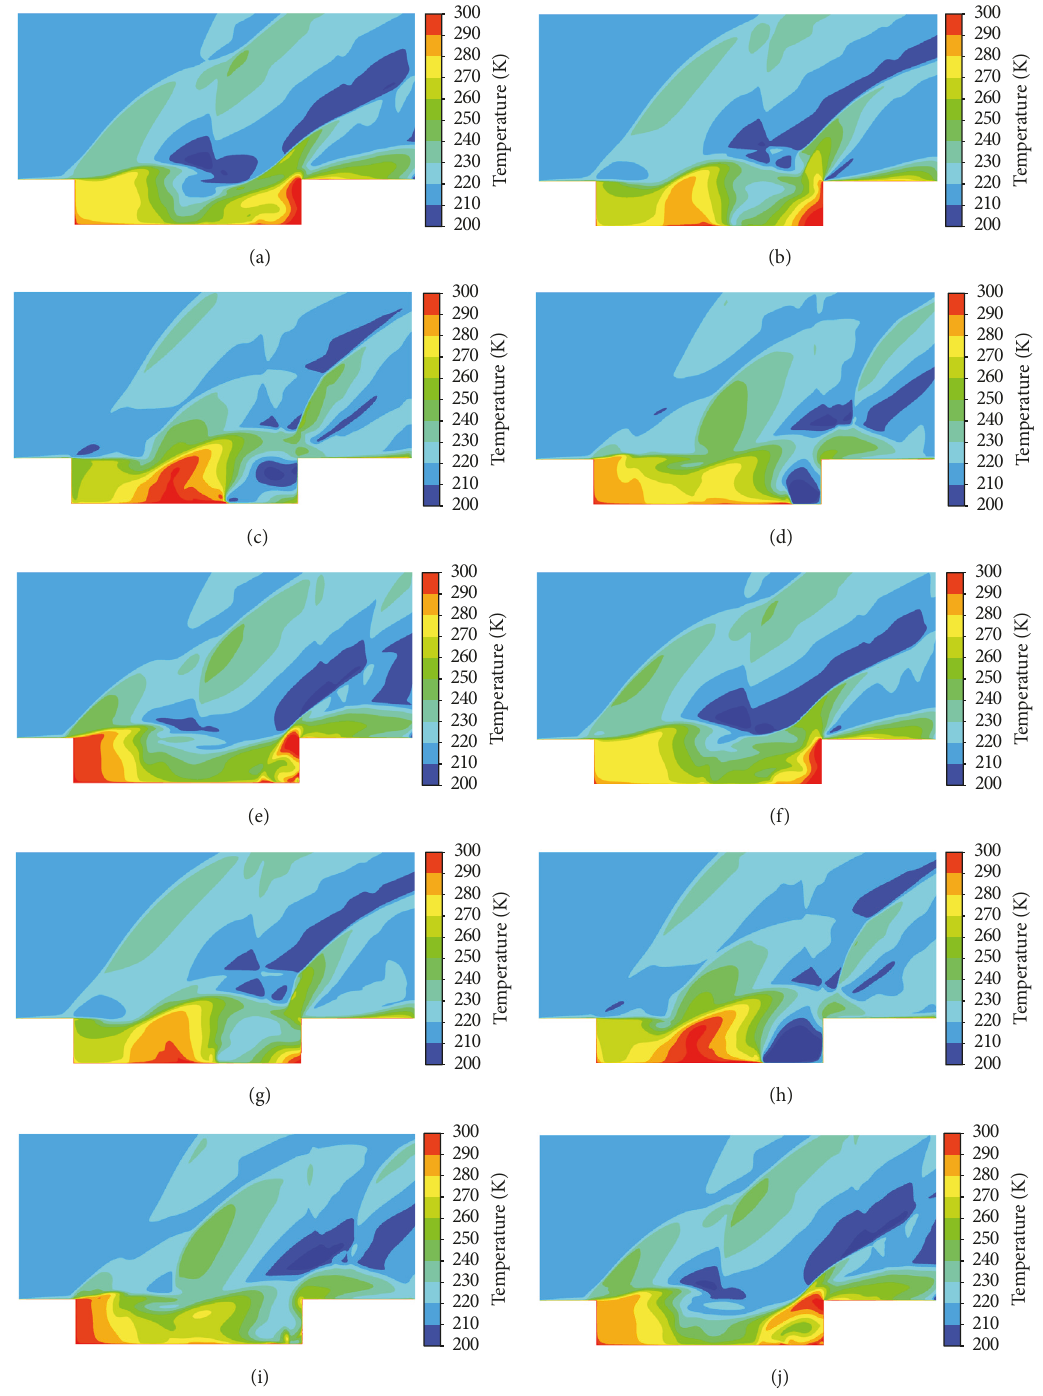
Figure 7: Temperature contours for the baseline case (a) 𝑡/𝑡 𝑅 = 0 , (b) 𝑡/𝑡 𝑅 = 0.11 , (c) 𝑡/𝑡 𝑅 = 0.22 , (d) 𝑡/𝑡 𝑅 = 0.33 , (e) 𝑡/𝑡 𝑅 = 0.44 , (f) 𝑡/𝑡 = 0.55 , (g) 𝑡/𝑡 = 0.66 , (h) 𝑡/𝑡 = 0.77 , (i) 𝑡/𝑡 = 0.88 , and (j) 𝑡/𝑡 𝑅 𝑅 𝑅 𝑅